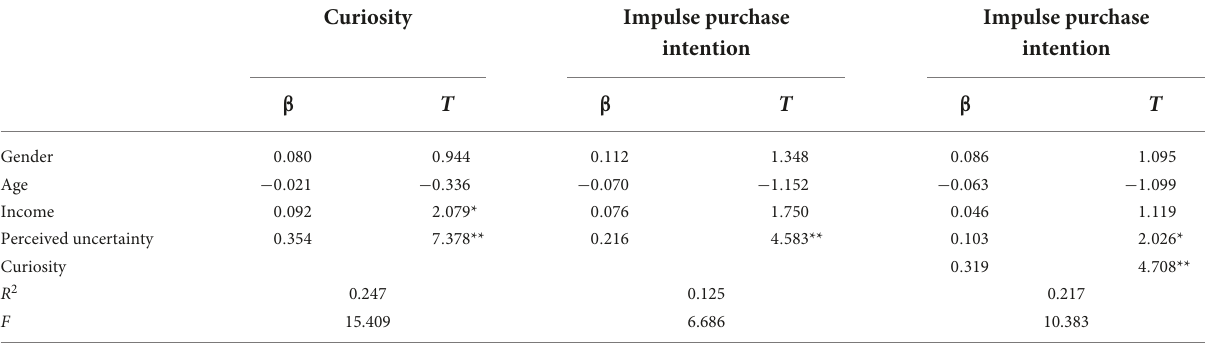
TABLE 6 Curiosity as a mediator in bootstrap analysis.